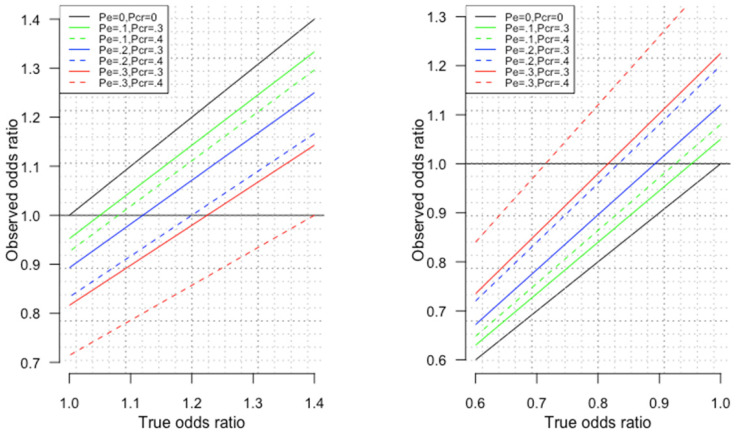
Observed odds ratio against the True odds ratio in the presence of different proportions of death before recruitment due to the exposure (PE) and different proportions of death before recruitment due to competing risk of the outcome (PCR) for true odds ratios large than 1 (left hand side) and smaller than 1 (right hand side, obtained by taking the inverse of the odds ratio).